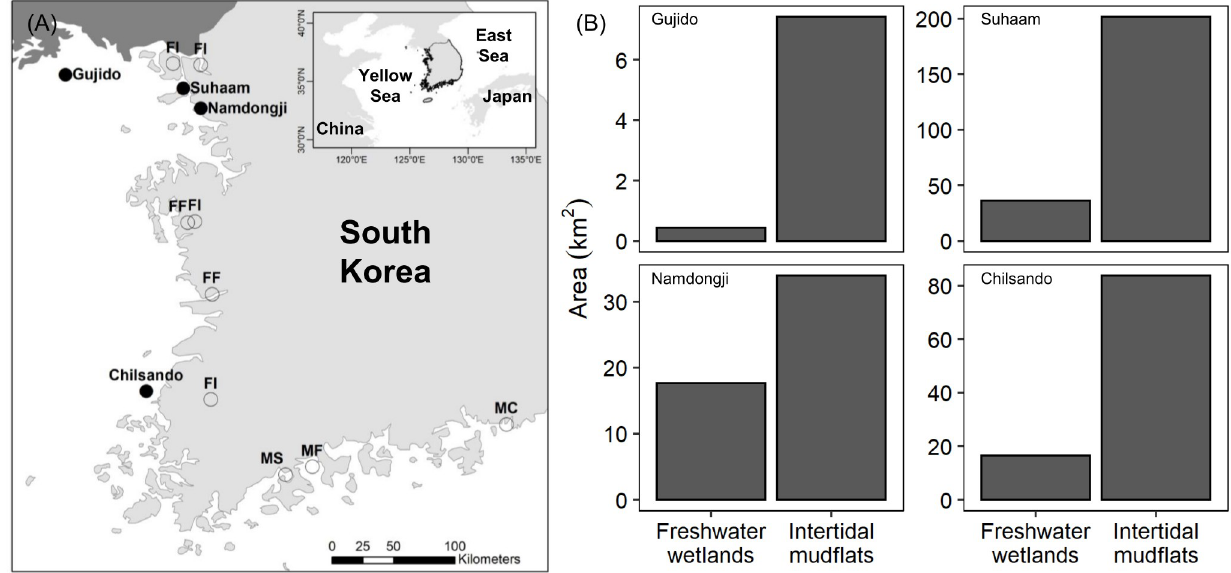
Fig 1. (A) Location of the studied breeding colonies of Black-faced Spoonbills and sampling sites of the potential prey items. (B) Area of the intertidal mudflats and freshwater wetlands within an 11-km radius of each colony. Light and dark gray represent South and North Korea, respectively. Circles represent the sampling sites of potential diets: FF: freshwater fish [49, 50], FI: freshwater invertebrates [51, 52], MF: marine fish [53], MS: marine shrimp [54], and MC: marine crustacean [55]. The base map was creasted using Natural